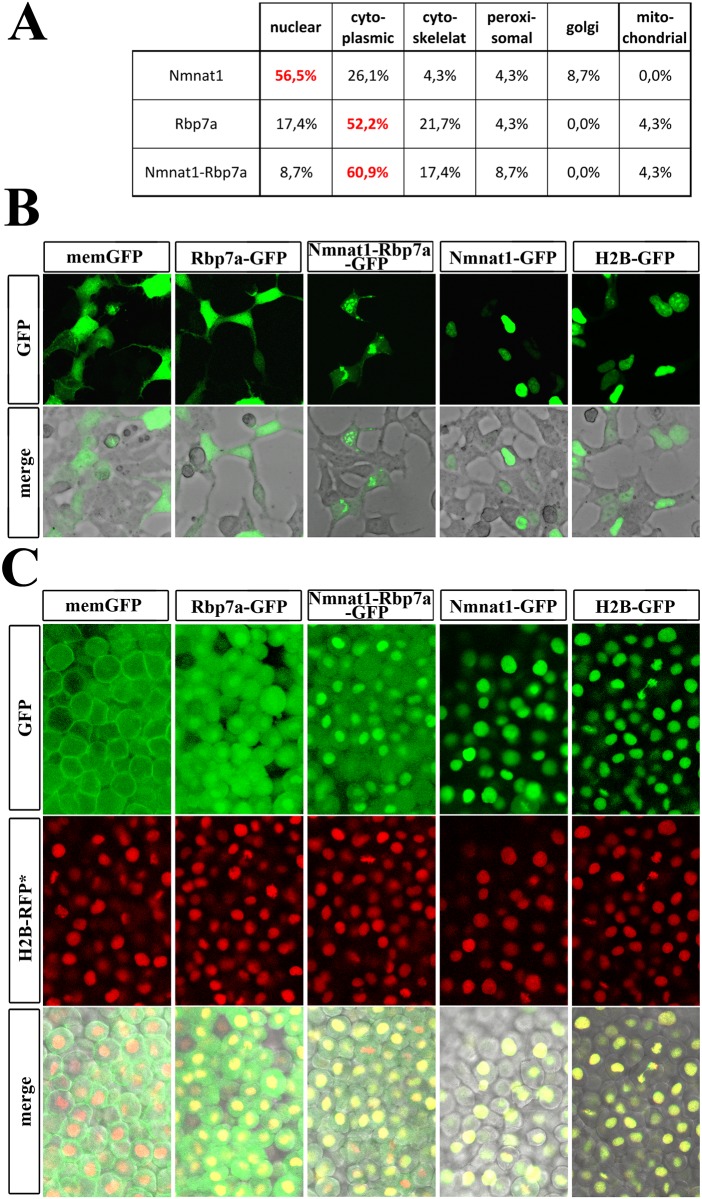
Subcellular localization of Nmnat1, Rbp7a and Nmnat1-Rbp7a proteins.[A] PSORT based predictions for sub-cellular location of Nmnat1, Rbp7a and Nmnat1-Rbp7a fusion. [B] Confocal image scans of HEK cells transfected with indicated fusion proteins. Note the strictly cytoplasmic and nuclear GFP-signals for Rbp7a-GFP and Nmnat1-Rbp7a-GFP, respectively. Nmnat1-Rbp7a-GFP transfected cells show weak GFP signals throughout the cytoplasm and stronger focal signals in association with the nuclei and cellular protrusions. [C] Confocal image scans of 6hpf embryo injected with mRNA encoding indicated GFP-tagged proteins. Co-injected mRNA encoding H2B-RFP (nuclear RFP, middle column) was used as loading control and to outline nuclei. Control injections of H2B-GFP and memGFP (membrane GFP) were used to document GFP/RFP co-expression. Rbp7a-GFP and Nmnat1-Rbp7a-GFP both showed nuclear and cytoplasmic localizations; but Nmnat1-GFP was only found in the nucleus.